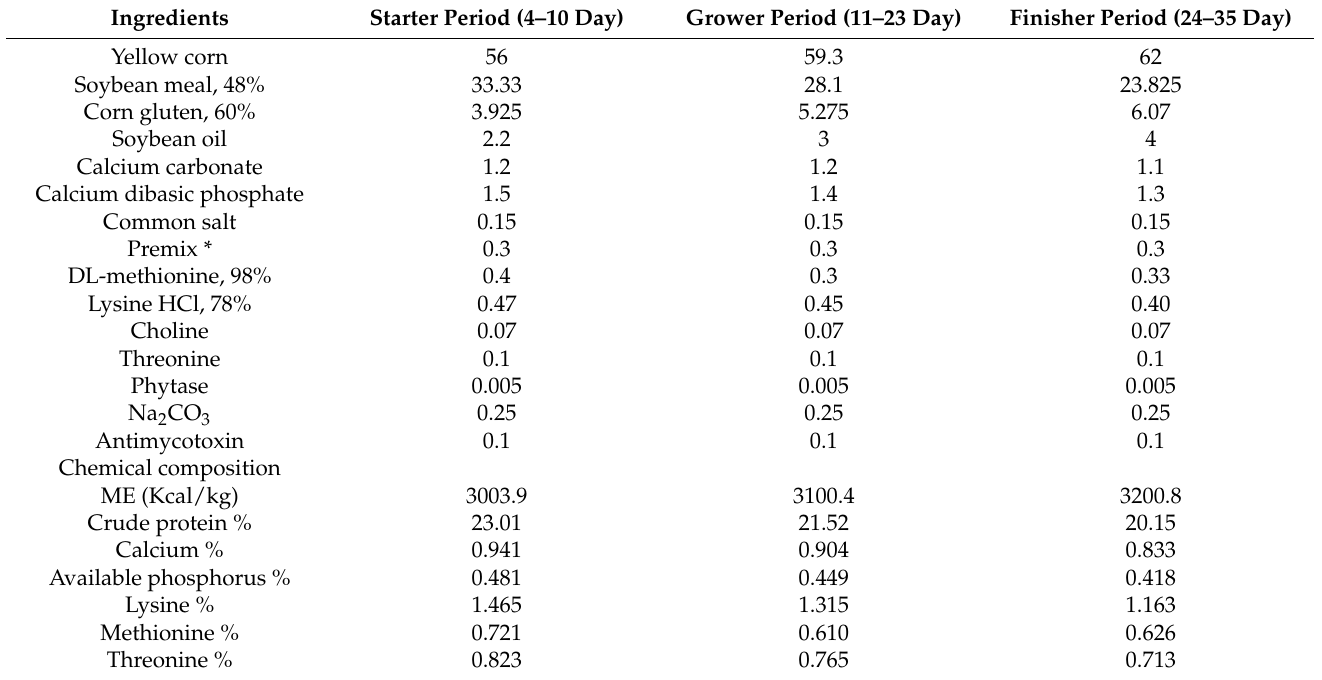
Table 1. Proximate and chemical composition of the experimental diets